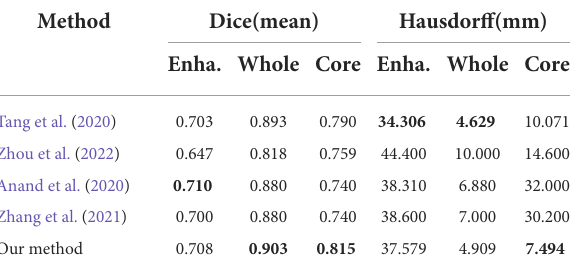
TABLE 8 Comparison to other methods on BRATS2020 validation